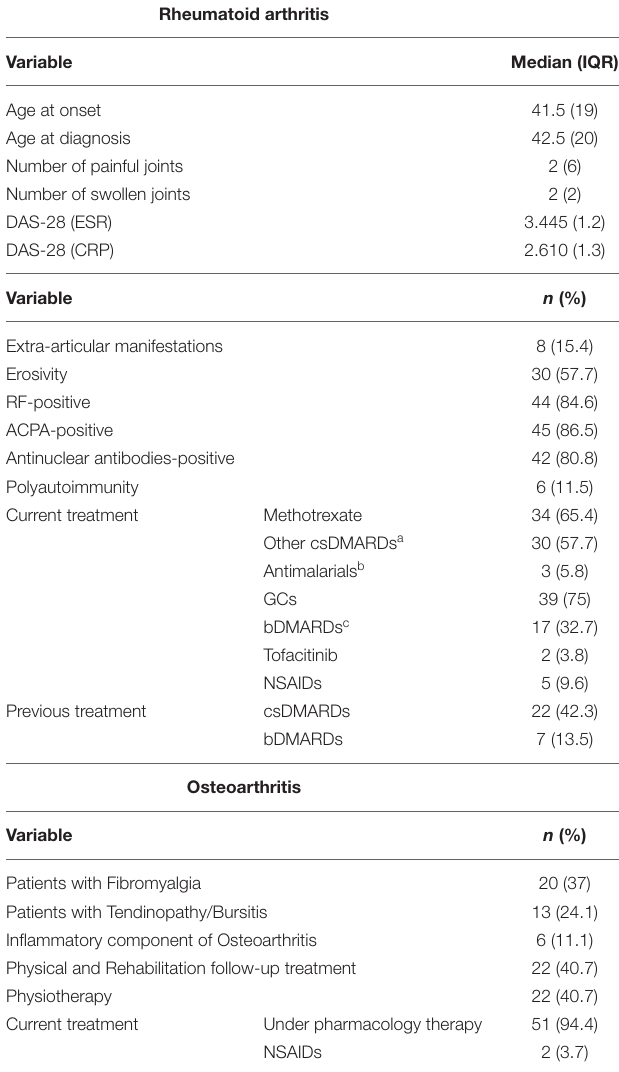
TABLE 2 | Rheumatoid arthritis and osteoarthritis